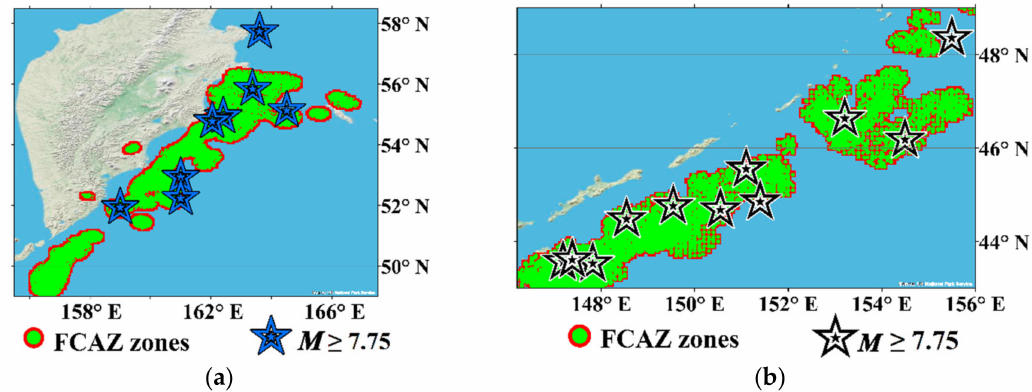
Figure 8. FCAZ zones prone to earthquakes with M ≥ 7.75 and the epicenters of earthquakes with M ≥ 7.75: Pacific Coast ( a ) of the Kamchatka Peninsula; ( b ) of the Kuril